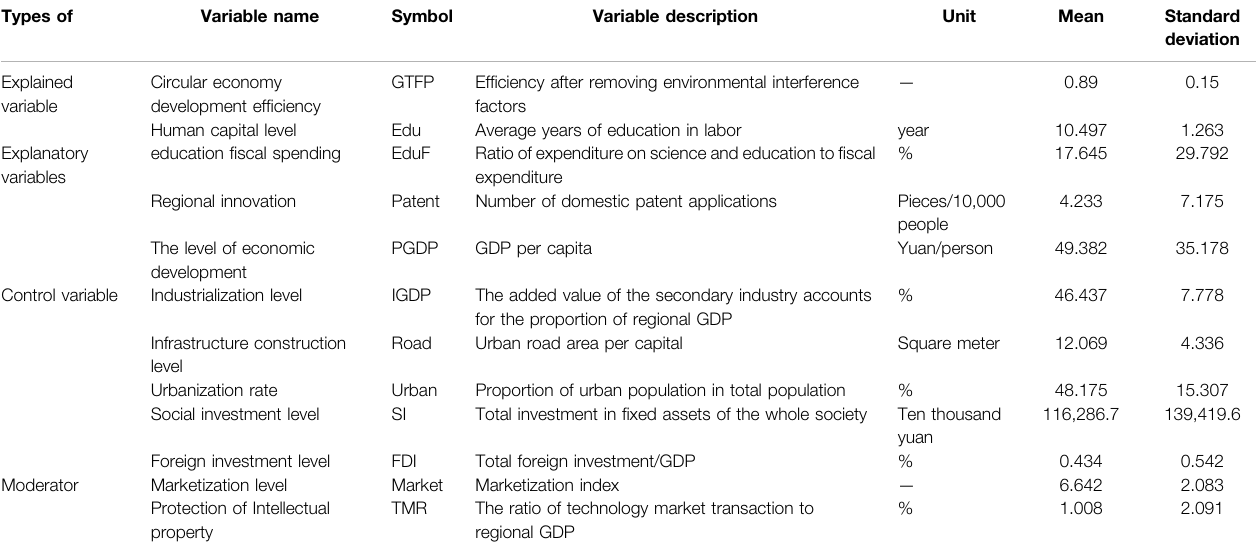
TABLE 2 | The Descriptive variables of tobit